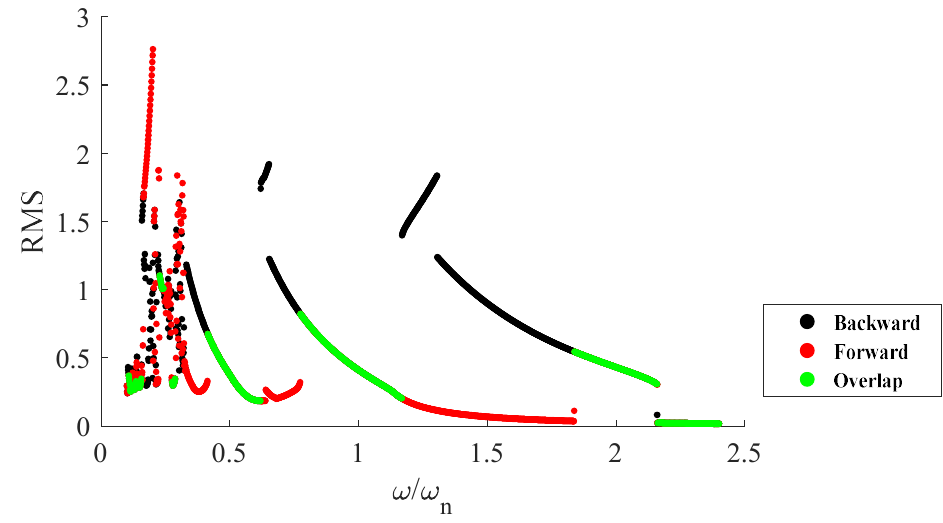
Figure 8. RMS diagram of the forward and backward simulations, case 1.